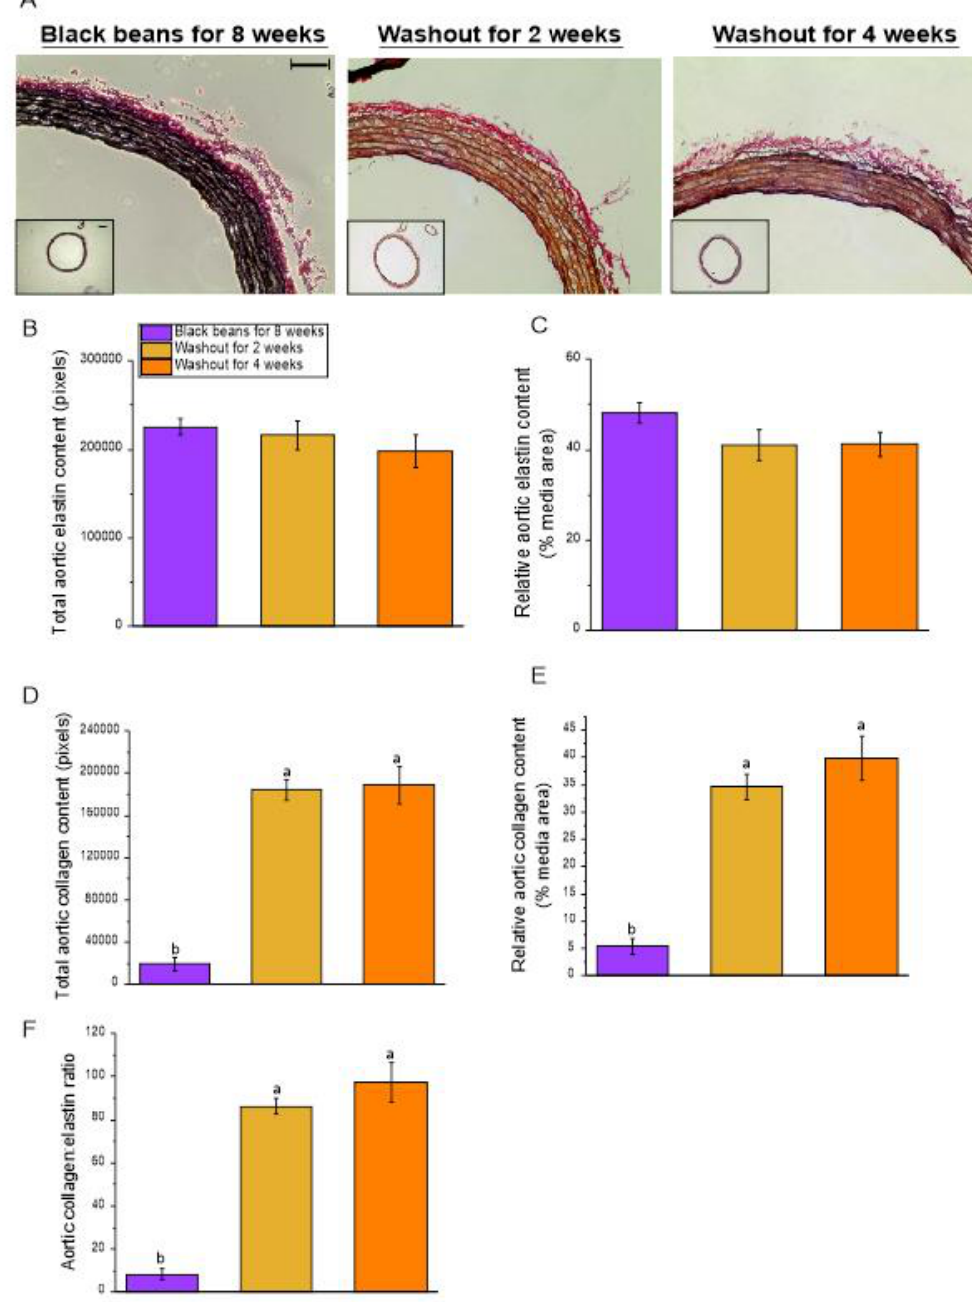
Figure 5. Phase 2: Large-artery elastin and collagen in SHR. ( A ) Representative cross-sections (20 × objective) of aorta stained for elastin (black) and collagen (red); ( B ) Elastin content in aorta as total area; ( C ) Elastin content in aorta as % media area; ( D ) Collagen content in aorta as total area; ( E ) Collagen content in aorta as % media area; ( F ) Aortic collagen:elastin ratio. Aortic cross-sections were stained with an Elastin Stain Kit (Sigma); ImageJ was used to quantify elastin (area of blackness) and collagen (area of redness) content. Inset: aortic cross-sections (4 × objective). Scale bar applies equally to all aorta images (bar = 50 µ m). Data are expressed as mean ± SEM ( n = 4–7 / group). Di ff erent letters represent significant di ff erences ( p < 0.05). An absence of letters indicates no statistical di ff erences. Abbreviations: SHR, spontaneously hypertensive rat.